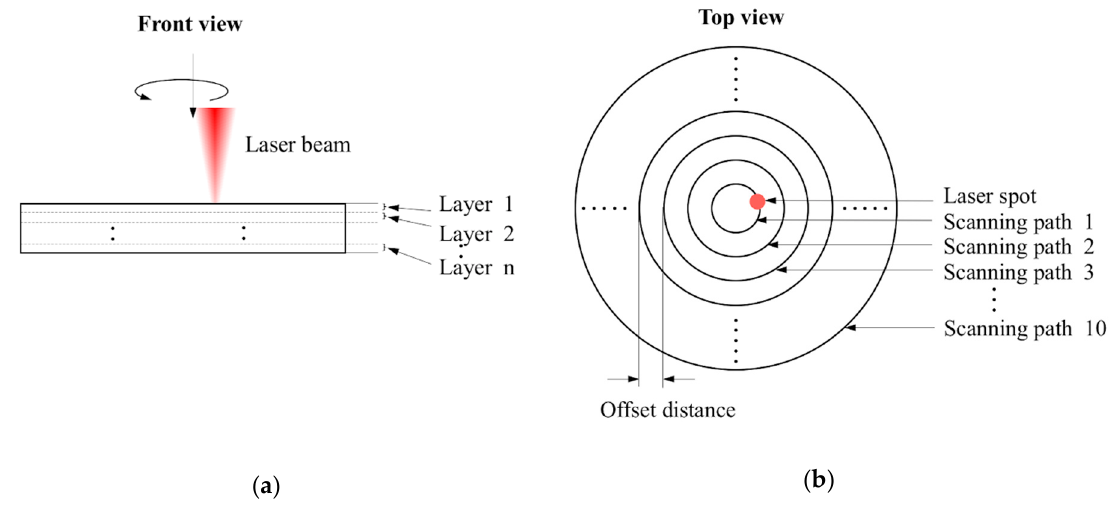
Figure 2. Schematic diagram of laser trepanning, where ( a ) represents the front view, while ( b ) corresponds to top view.